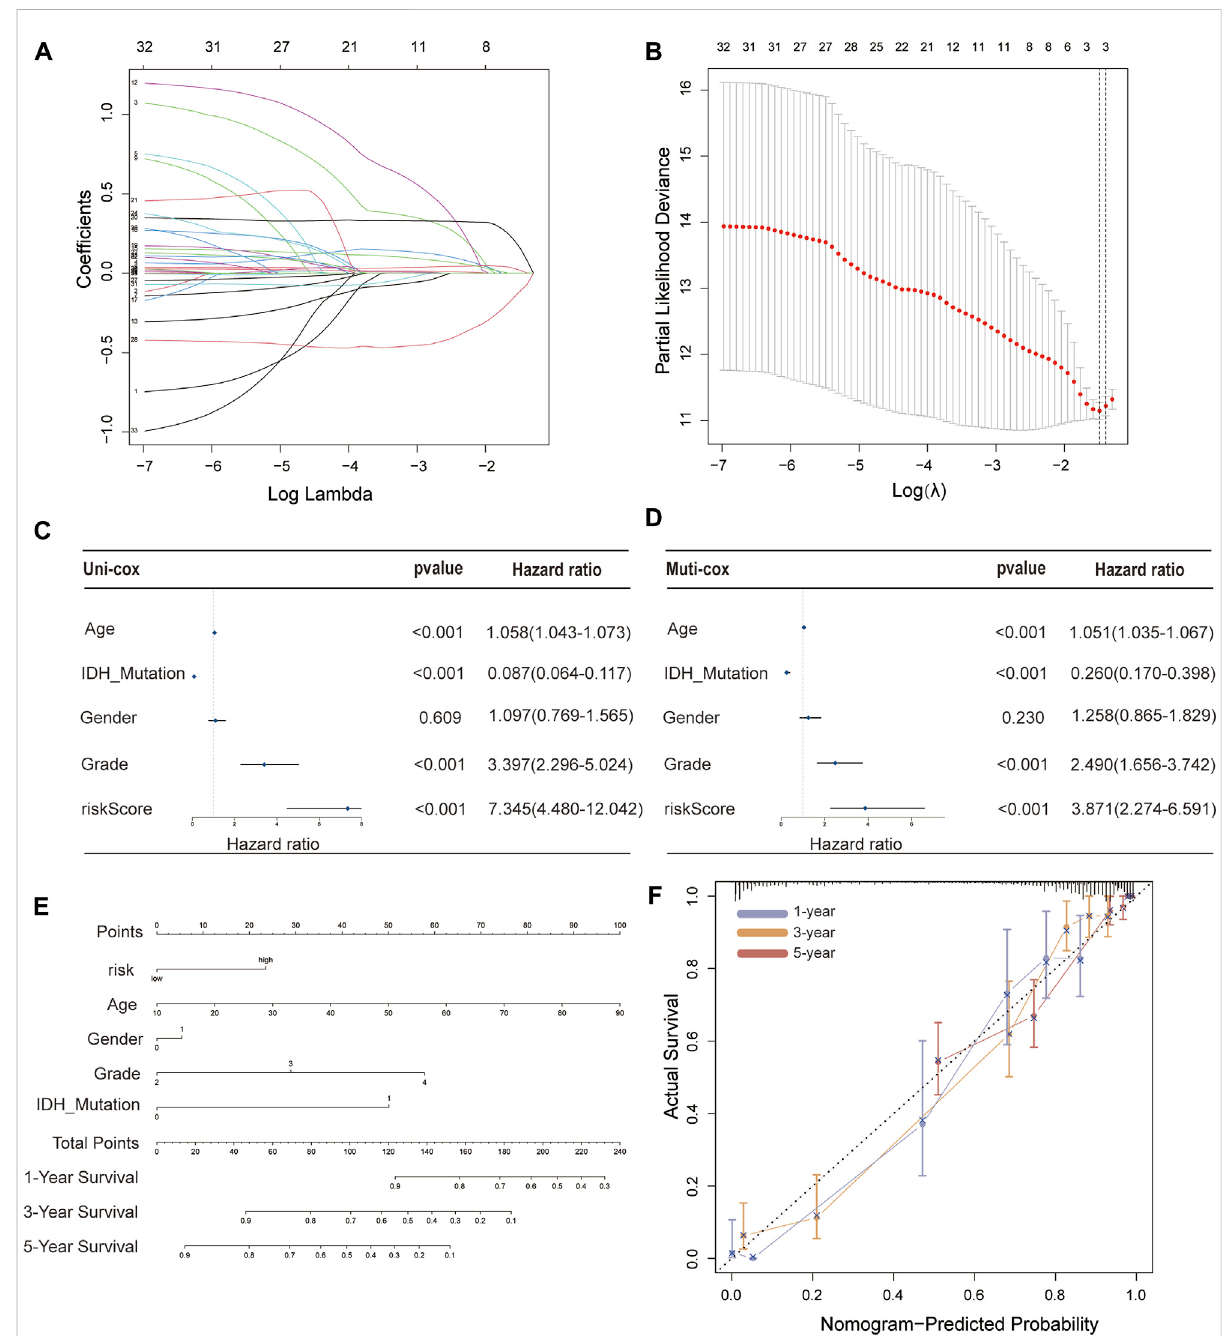
FIGURE 3 Construction of a 3-FRL signature and the analysis of independent prognostic potential. (A,B) The least absolute shrinkage and selection operator (LASSO) regression was performed with the minimum criteria. (C) Results of the univariate Cox regression analysis and multivariate Cox regression analysis regarding OS of the 3-FRLs signature. (D) Nomogram of OS over time for glioma patients. (E) This calibration curve is used to assess the accuracy of the nomogram model, and the dashed line represents the ideal nomogram. (F) The calibration curve for evaluating the accuracy of the nomogram model. The dashed diagonal line in grey colour represents the ideal